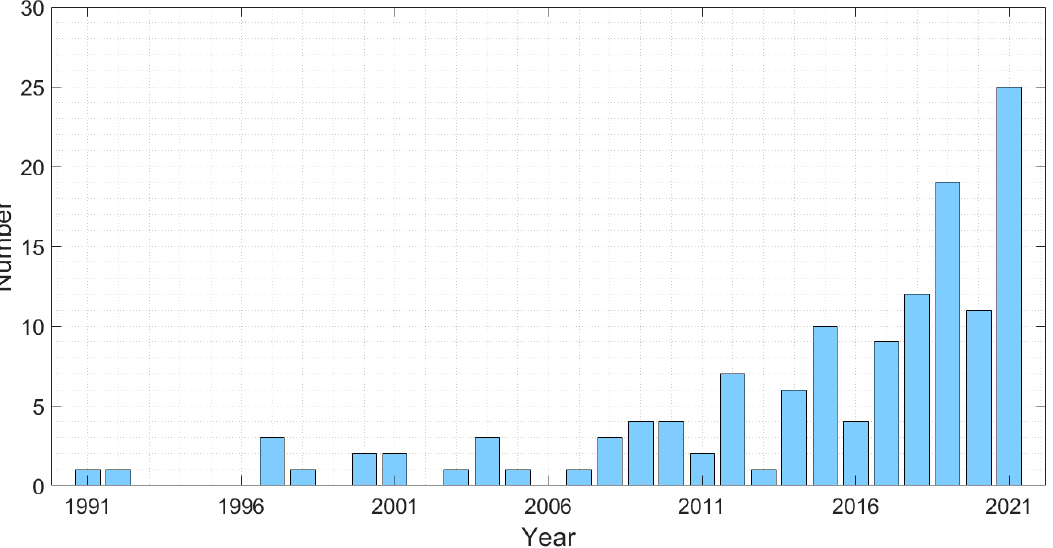
Figure 1. A statistical graph of papers over the past 30 years on water-body segmentation in SAR images. The counted papers are mainly from Molecular Diversity Preservation International (MDPI), Institute of Electrical and Electronics Engineers (IEEE) and Elsevier.